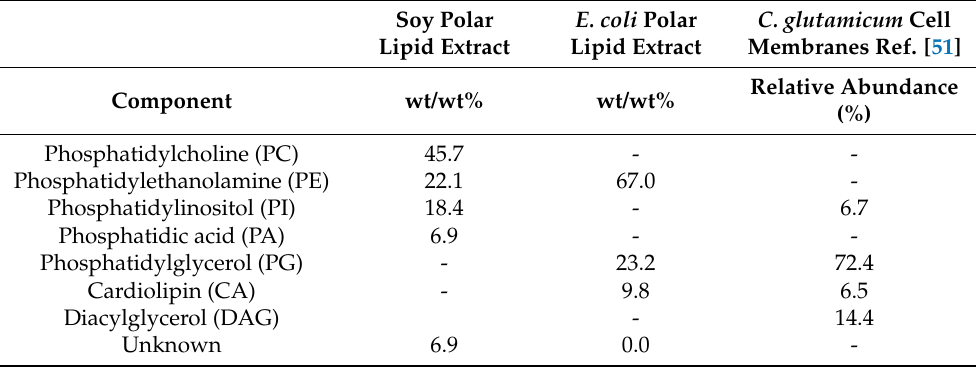
Table 1. Lipid components of soy polar extract, E. coli polar extract, and C. glutamicum cell membranes. Note that the information about the components of the soy polar lipid and E. coli polar lipid extract is from the website of Avanti Polar Lipids, Inc. (https://avantilipids.com/) and the information about the components of C. glutamicum cell membranes is cited with the permission of the author from Nagakubo, T. et al. Mycolic acid-containing bacteria trigger distinct types of membrane vesicles through different routes. iScience 2021 , 24 ,